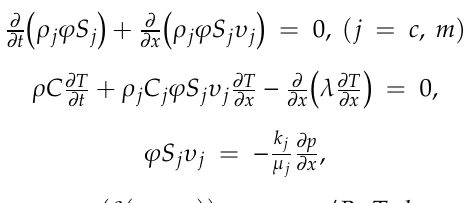
Figure 2. Layout of zones in the reservoir.